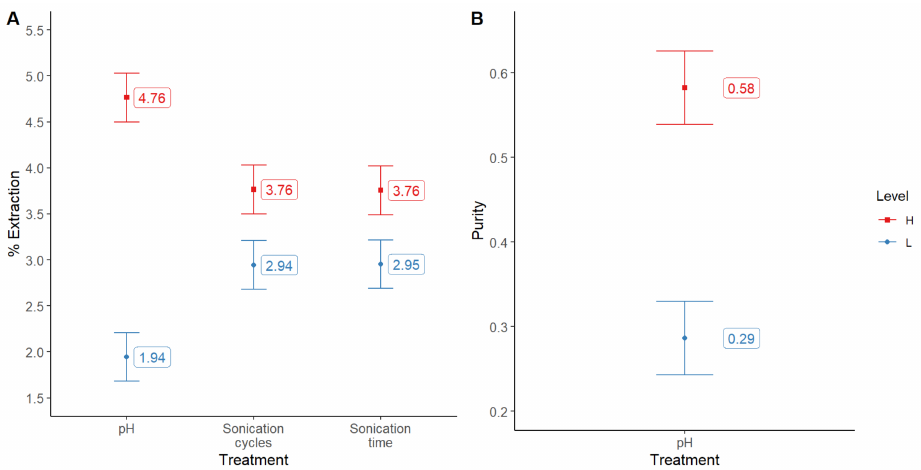
Figure 4. Comparative extraction yields ( A ) of phycocyanin (%) as function of several factors (pH, L = 5 H = 7; sonication cycles, L = 2 H = 4; sonication time, L = 30 s H = 60 s), and ( B ) purity of the pigment as function of pH level. Bars show the means and least significant difference intervals for 95% confidence.